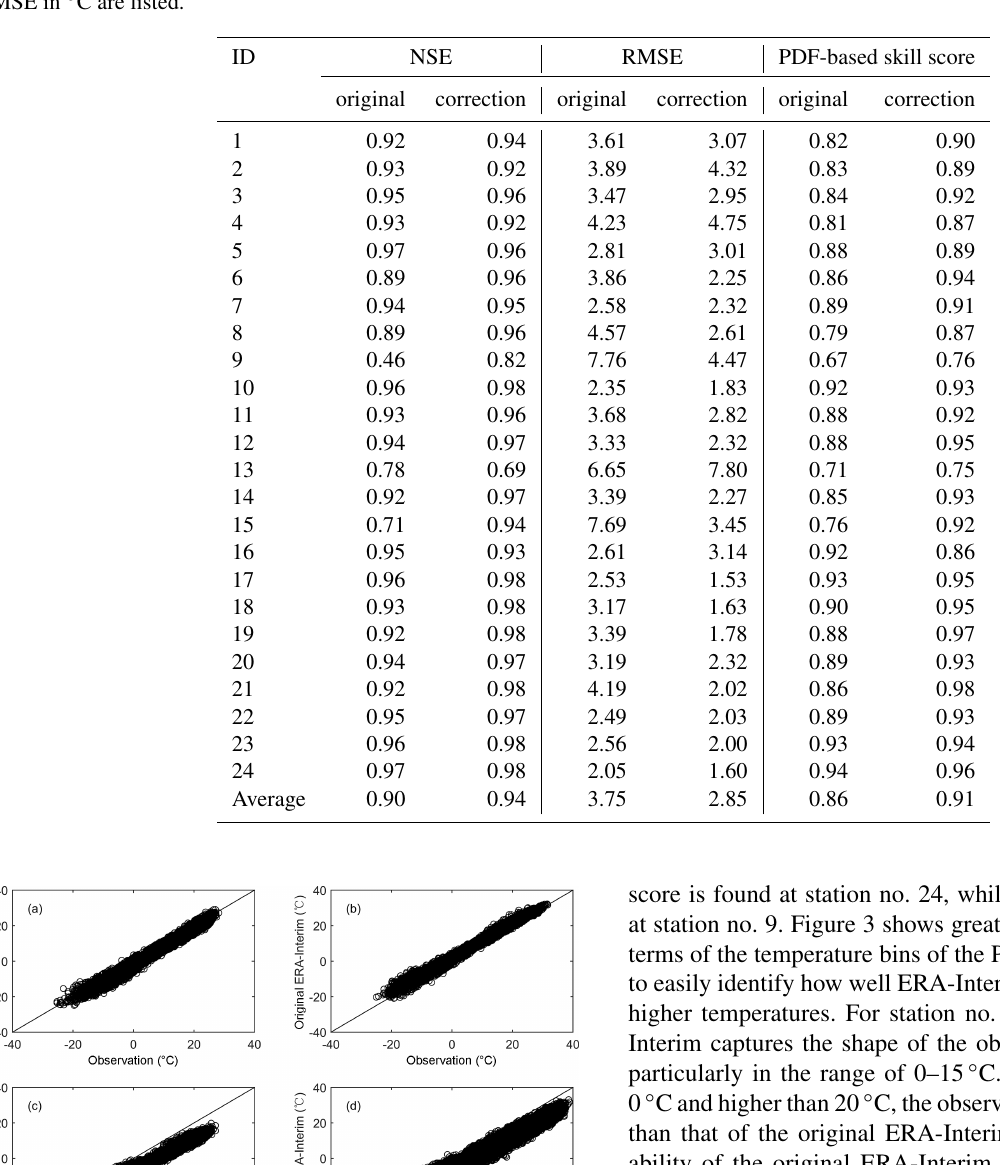
Table 3. Comparison of the original and corrected ERA-Interim temperature with daily observations. The NSE, PDF-based skill score, and RMSE in ◦ C are listed.